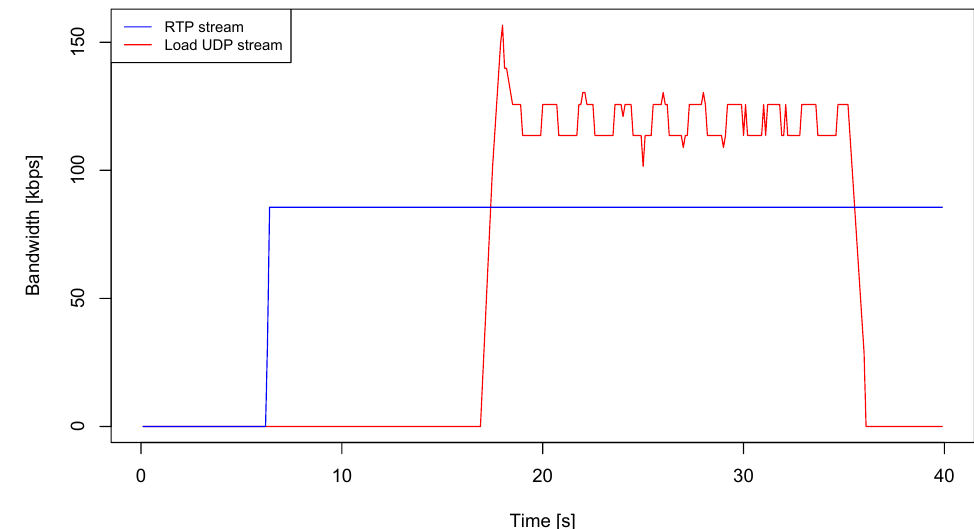
Figure 4. Bandwidth distribution with Kamailio in default configuration.